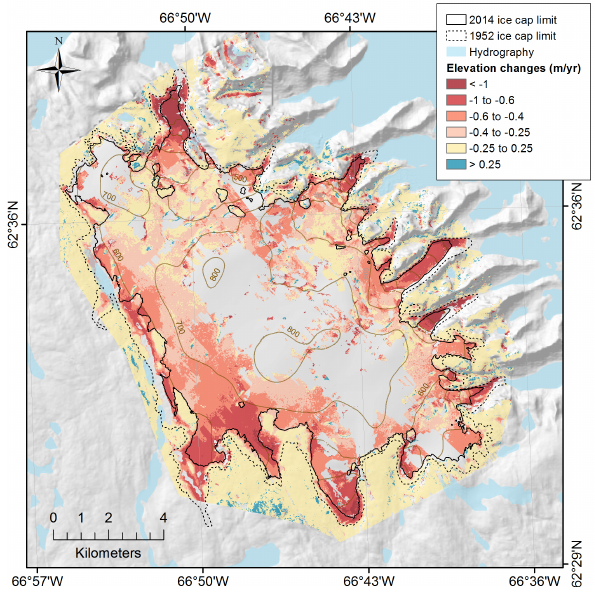
Figure 3. Elevation change rates (ma − 1 ) on Grinnell Ice Cap be- tween August 1952 (Aerial photo DEM) and August 2014 (Pléiades DEM). For this figure as well as for the next ones, no color (i.e. hill- shade is visible) represents no